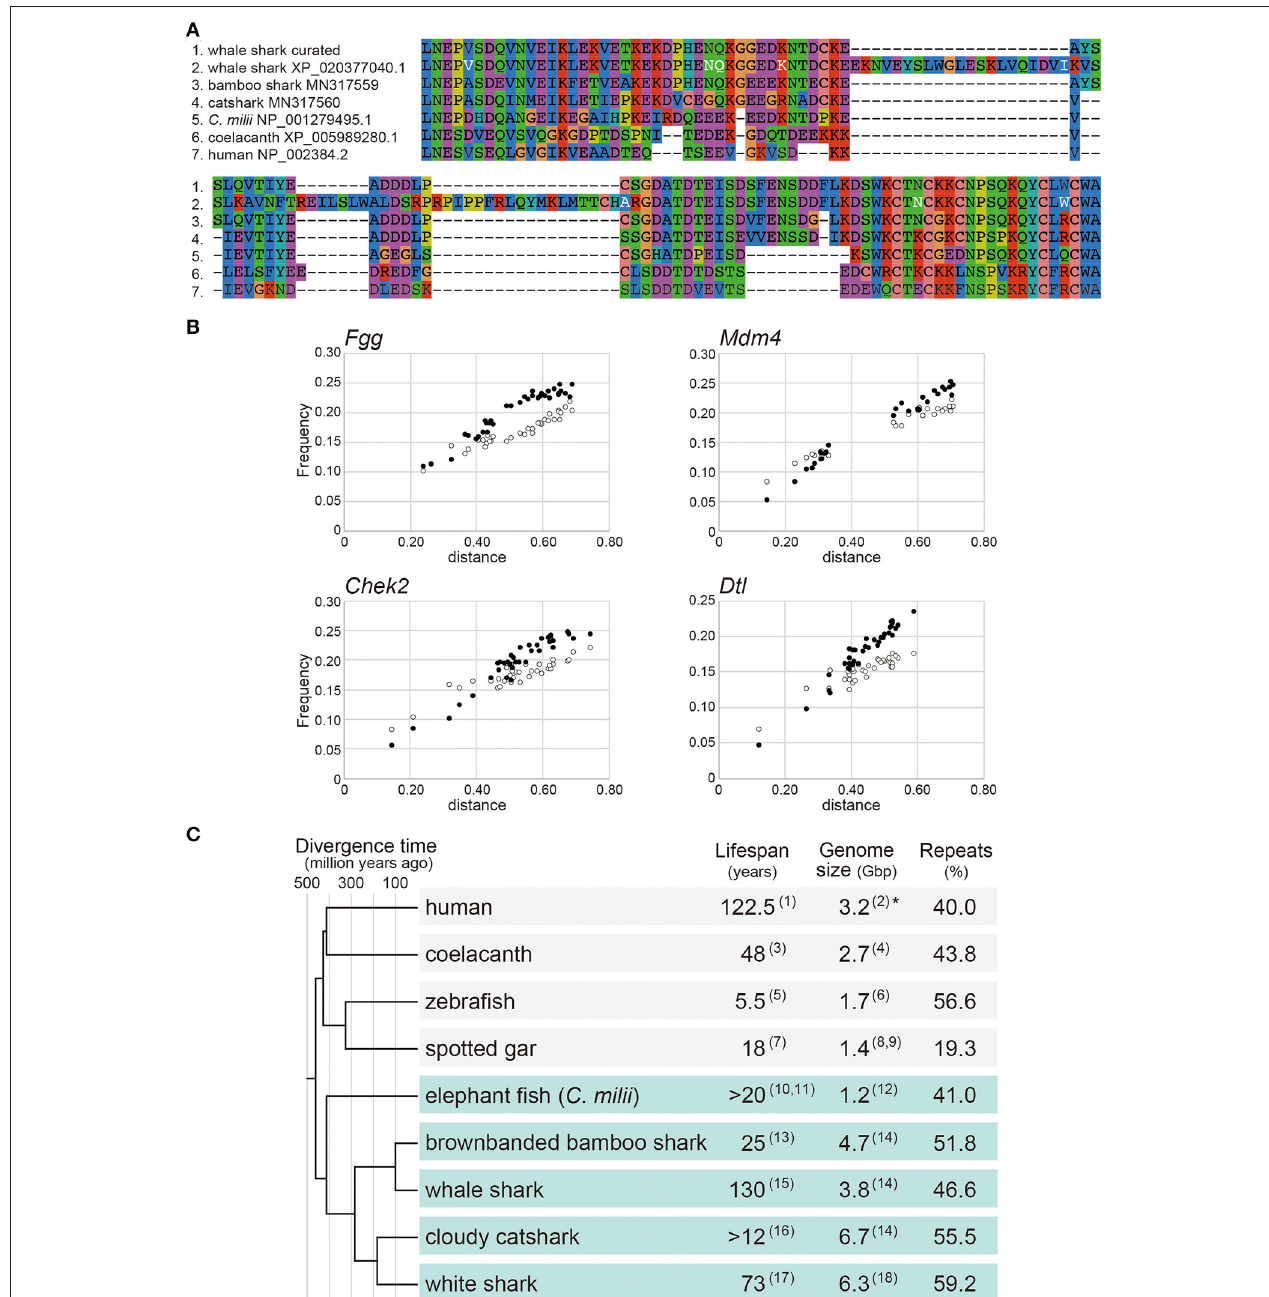
FIGURE 1 | Reanalysis of shark molecular sequences. (A) Multiple alignment of Mdm4 for the amino acid sequence stretch corresponding to the residue 241 to 325 of human Mdm4 (NP_002384.2 in NCBI). The residues in white letters indicate positively selected residues in the whale shark sequence identified previously (Marra et al., 2019), but most of them are neither unique to the whale shark nor included in the curated whale shark sequence. The GenBank accession ID for the curated whale shark sequence (top) supported by transcript sequencing is MN317558.1. Details of the transcript sequencing will be reported elsewhere. (B) Substitution saturation plots for transition and transversion of the coding region of the Fgg , Mdm4 , Chek2 , and Dtl genes chosen from those previously regarded as positively selected (Marra et al., 2019). Each dot indicates a pair of species in the dataset. The white and black dots indicate transitions and transversions, respectively. The horizontal axis indicates the distance based on the TN93 substitution model (Tamura and Nei, 1993). The vertical axis indicates the observed proportion of transition and transversion. The amino acid sequences were aligned with MAFFT v7.299b (Katoh and Standley, 2013) using the L-INS-i option. Nucleotide sequences were aligned based on the amino acid sequence alignment using the emboss tranalign tool. Unreliably aligned regions were removed using Gblocks v0.91b (Talavera and Castresana, 2007) based on the default parameters. Transversion and transition frequencies were calculated with the TN93 substitution model using the DAMBE program (Xia, 2018). The details of the sequences used for the analysis are included in Supplementary Data (https://doi.org/10.6084/m9.figshare.13521329).